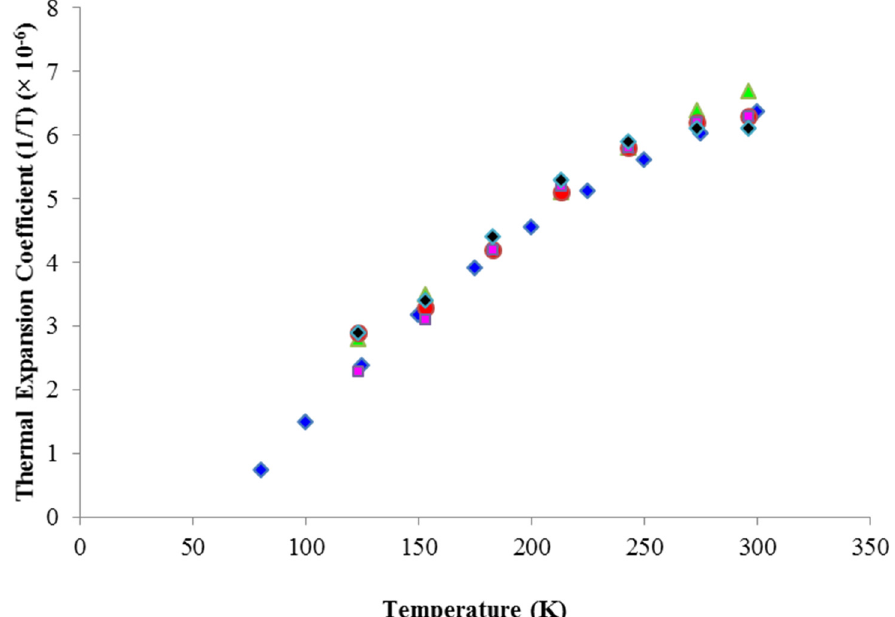
Figure 25. Thermal expansion coefficient as a function of absolute temperature for the undoped isotropic sesquioxide laser materials Sc 2 O 3 (blue) [30] and Y 2 O 3 (red) [59], and the 10 at. % Yb-doped laser material Yb:Y 2 O 3 (green) [59], the 1 at. % Yb-doped material Yb:Sc 2 O 3 (pink) [59], and 1 at. % Yb-doped material Yb:Lu 2 O 3 (black) [59].